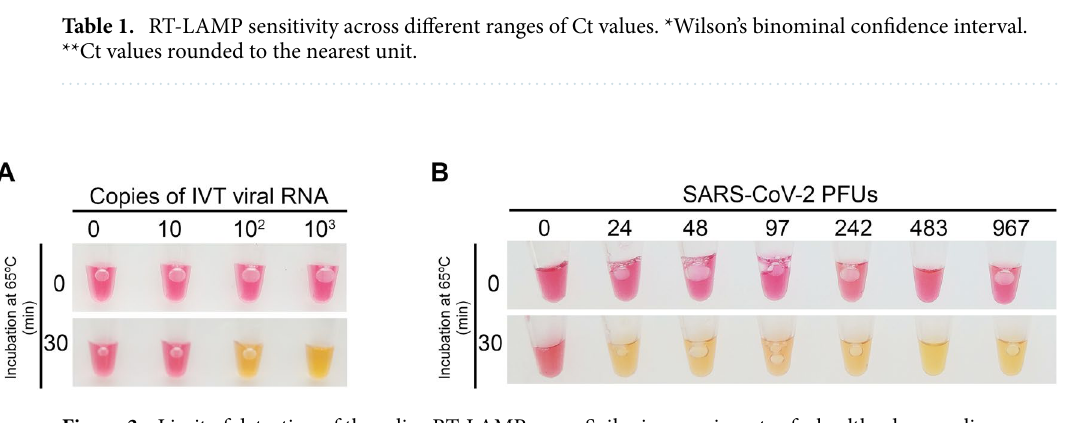
Figure 3. Limit of detection of the saliva RT-LAMP assay. Spike-in experiments of a healthy donor saliva with ( A ) tenfold dilutions of in vitro transcribed (IVT) viral RNA (N-gene) and ( B ) in vitro propagated SARS-CoV-2 virions. Saliva samples were processed as described in “Materials and methods” and 2 μL were analyzed by colorimetric RT-LAMP. PFUs plaque forming units. Figures are representative of three independent